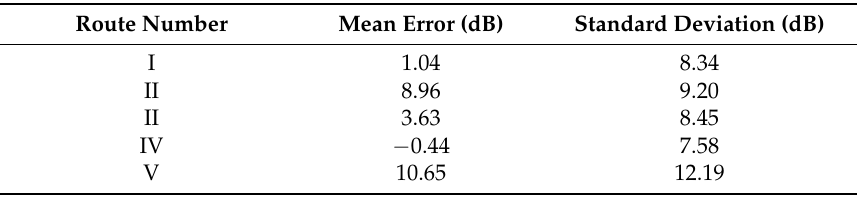
Figure 4. Comparison between measurements and the propagation model. Table 2. Mean error and standard deviation of the difference between the propagation model and measurements for each route.